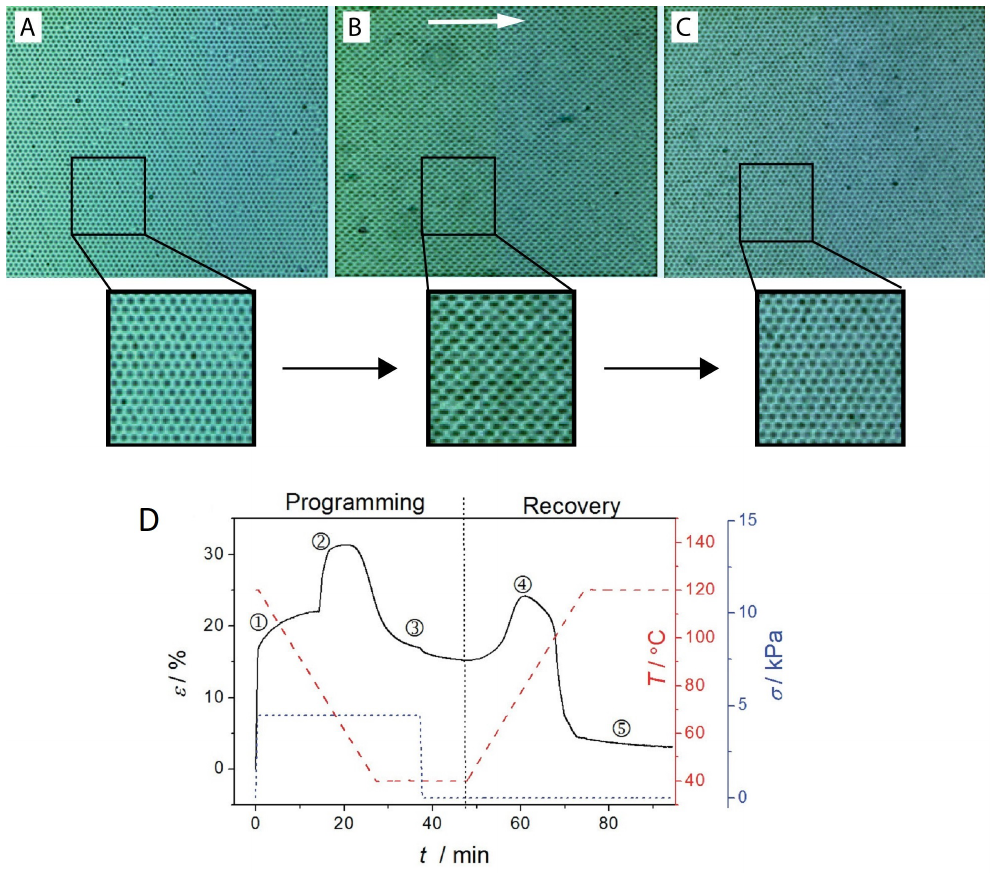
Figure 15. Shape memory effect (SMP) displayed by a cholesteric terpolymer film ( A ) stretched at 110 ◦ C ( B ) quenched to room temperature and ( C ) recovering its original shape upon reheating back to 110 ◦ C. ( D ) Shape memory effect of a film of a terpolymer and its subsequent recovery on heating shown as function of time. Red dashed line represents the response as a function of temperature, blue dotted line shows the strain applied and solid black line the strain response. Numbers 1 and 5 correspond to different isotropic states and 2 to 4 correspond to various SmA polymorphism change during shape memory effect. Reprinted with permission from Mahajan et al., Macromolecules , 2017 , 50 , 5929–5939 and Ahn et al., ACS Nano , 2011 , 5 , 3085–3095